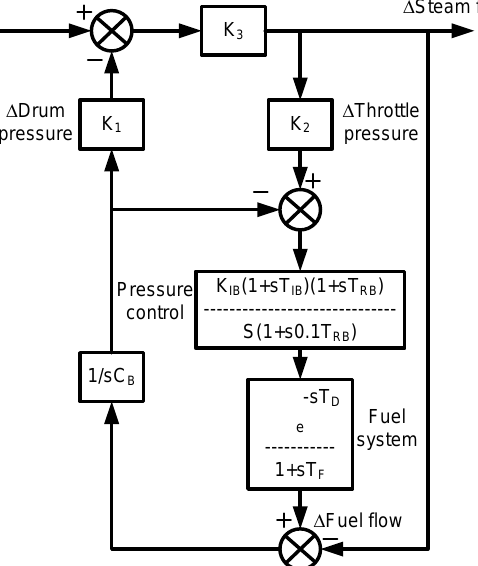
Figure 2. Block diagram of the boiler dynamics configuration system.